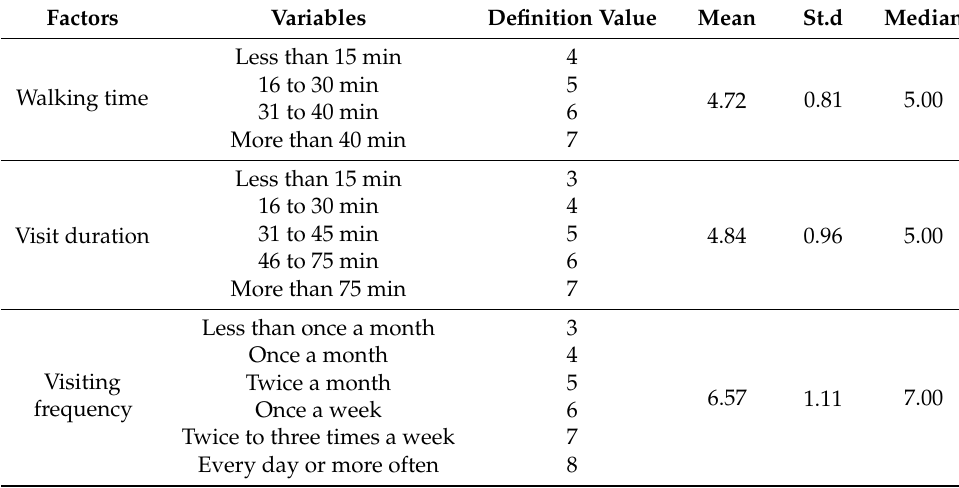
Table 1. Variable definition and descriptive statistics.